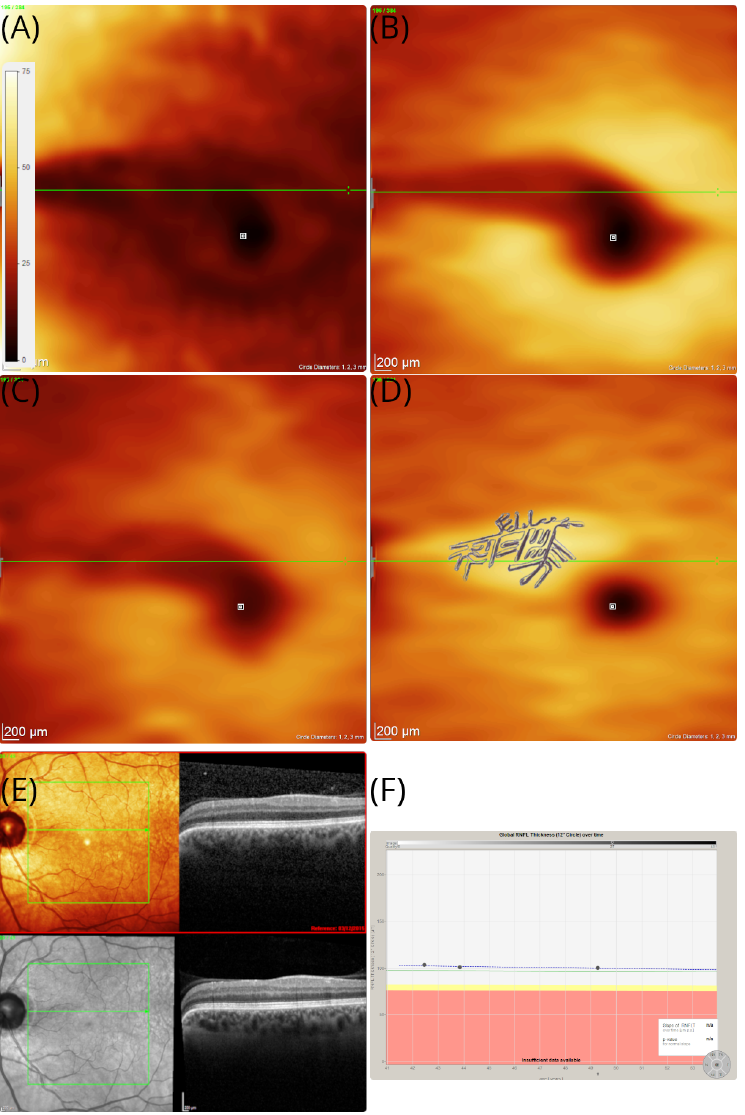
Figure 2. OCT in patient #1. The OCT thickness maps of the left eye revealed an area of sectorial atrophy of the retinal nerve fibre ( A ) RNFL (dark shaded arcuate area in the macula), ( B ) GCL